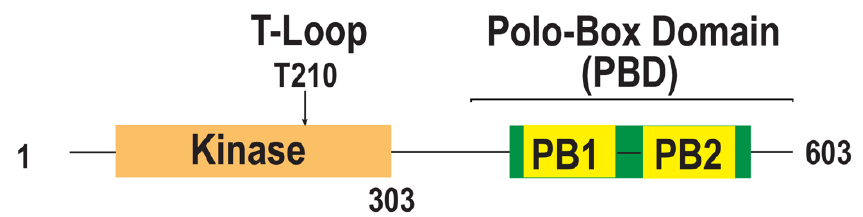
Figure 1. Domain organization of PLK1. A schematic diagram of human PLK1 protein and its domain organization. PLK1 contains the serine/threonine kinase domain (KD: orange), the polo-box domain (PBD: green), and the linker between two domains. The PBD consists of polo-box 1 and 2 (PB1 and PB2: yellow). PLK1 activation requires the phosphorylation of conserved Thr residues within the T-Loop.